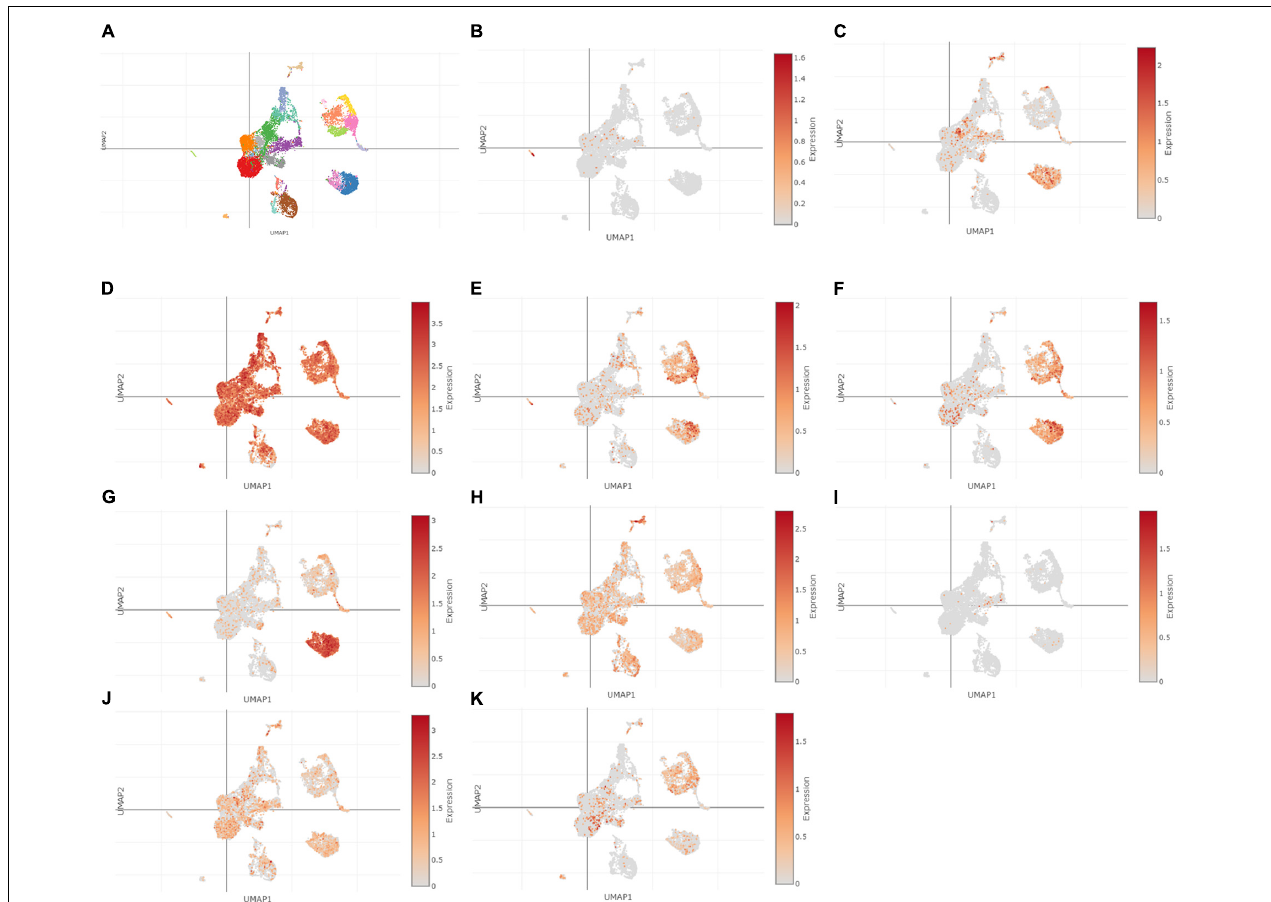
FIGURE 12 | The hub genes were highly expressed in the human fetal heart. (A) The overall clustering of cells in the human fetal heart. (B–K) The hub genes were validated to be highly expressed in the fetal human heart, such as IL-6 (B) , PTGS2 (C) , JUN (D) , NQO1 (E) , NOS3 (F) , LEPR (G) , NAMPT (H) , CDKN2A (I) , CDKN1A (J) , and Snai1 (K)